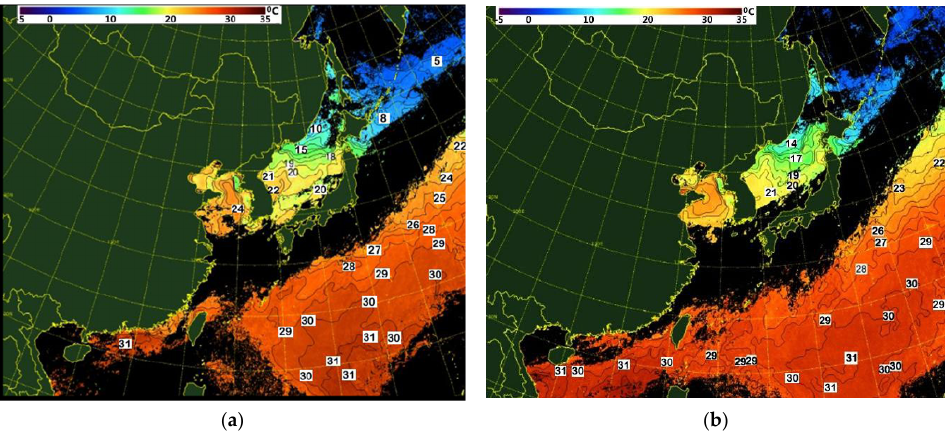
Figure 6. SST analysis (°C) at ( a ) 09:00 LST, 4 July 2015, and ( b ) 09:00 LST, 5 July. Long black areas oriented southwest to northeast in ( a ) and ( b ) indicate cloud bands, implying the MLCT corresponds to Figure 4a,b, and Figure 5a in ( a ) and Figures 7 and 8 in ( b ), respectively. STS Linfa moved to the South China Sea of 31 ◦ C SST, passing by Luzon island of the Philippines. TY Chan-Hom also moved to the Kuroshio current of 31 ◦ C SST in the east of the Philippines, gaining more energy from the warm sea to be intensified and the MLCT strongly attracts two typhoons in Figures 7 and 8.